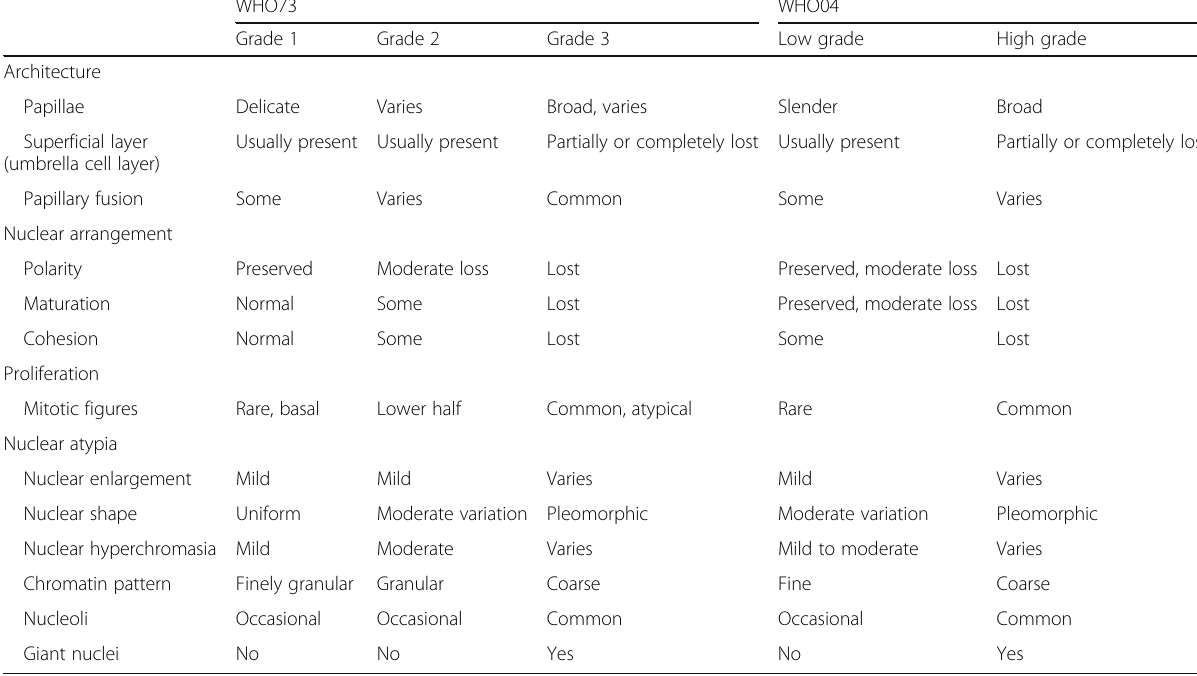
Table 1 The microscopic features with descriptions for each grade (WHO73/ 04)